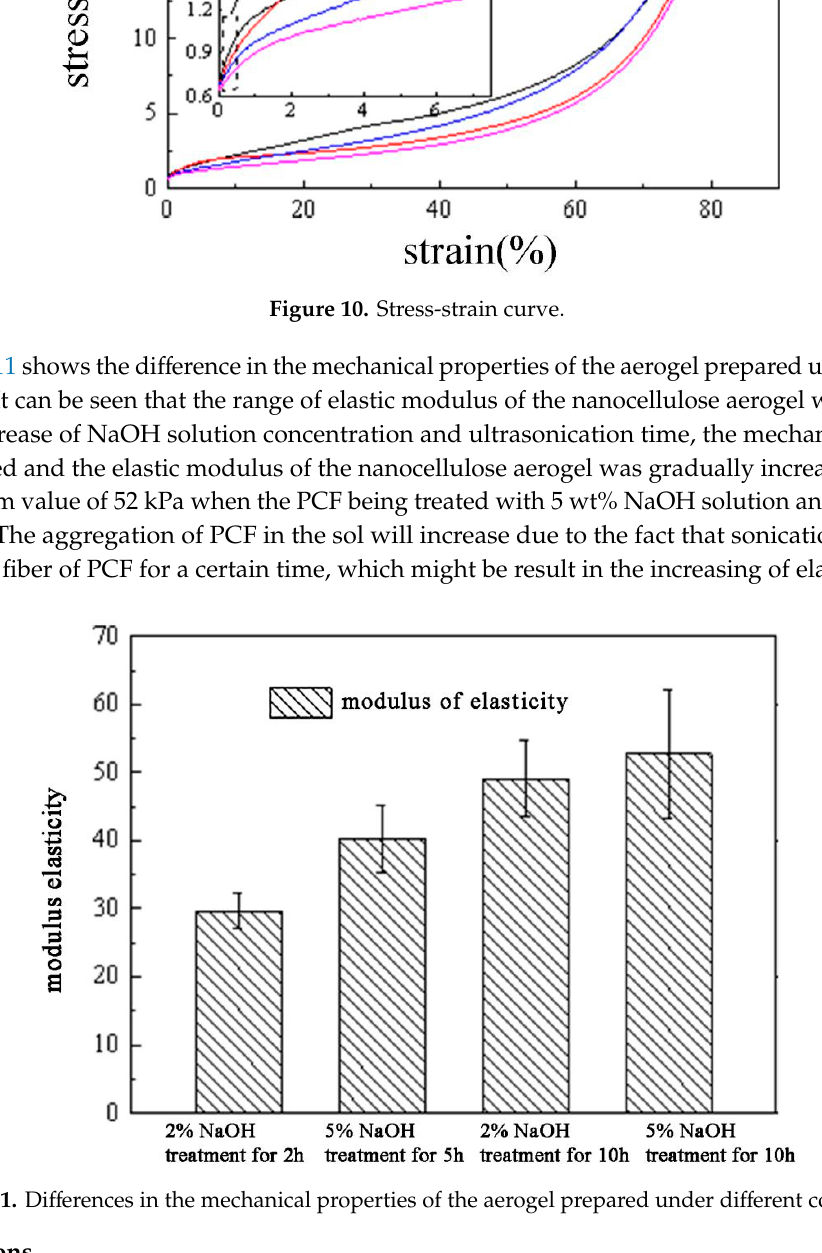
Figure 11. Di ff erences in the mechanical properties of the aerogel prepared under di ff erent Figure 11. Differences in the mechanical properties of the aerogel prepared under different conditions.